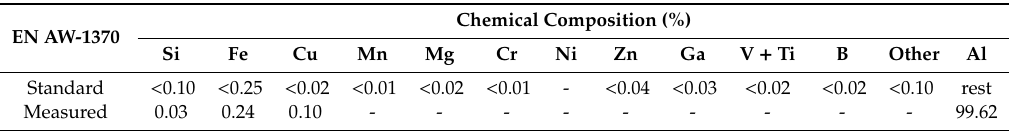
Table 1. Standard composition of EN AW-1370 aluminium (adapted from [1], with permission from AENOR, 2014) and composition measured by SEM.